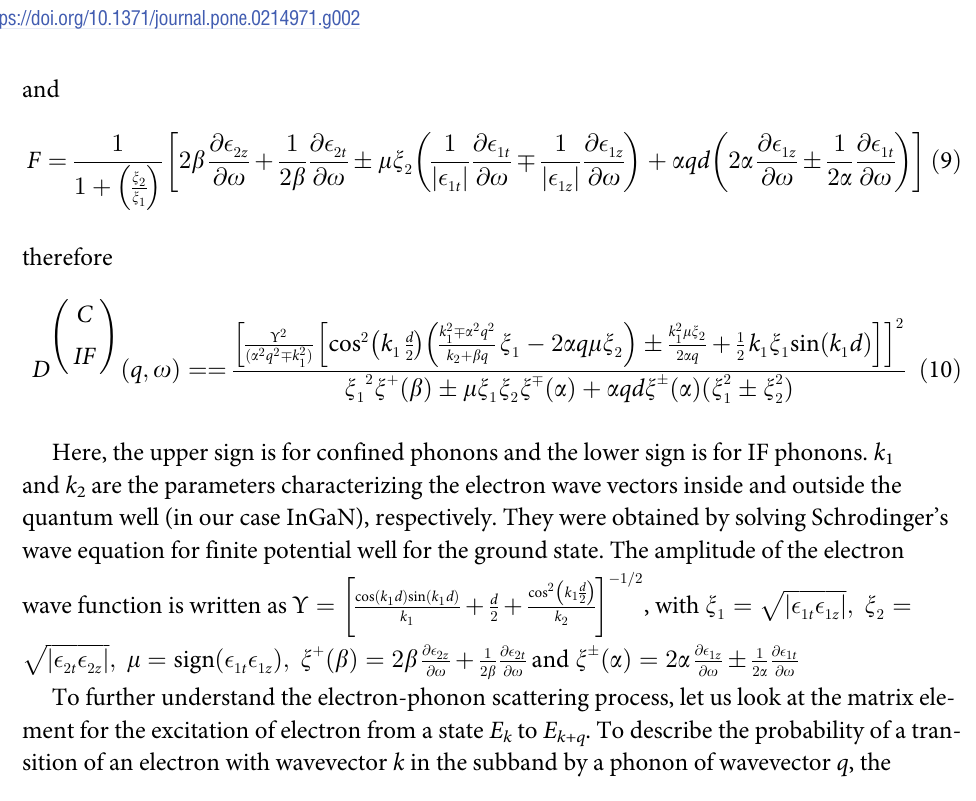
Fig 2. The frequency-dependent dielectric functions of GaN/InGaN/GaN QW. � 1 designated in black and red and � 2